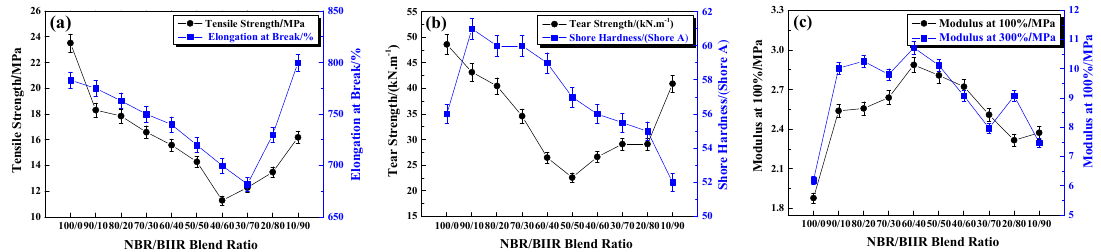
Figure 7 . Mechanical properties of NBR/BIIR with various blend ratios: ( a ) Effect of tensile strength and elongation at break; ( b ) effect of tear strength and shore hardness and ( c ) effects of 100% and 300% module.